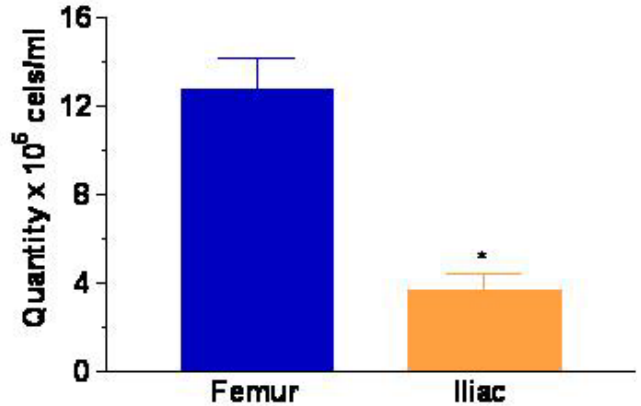
FIGURE 4 - Mononuclear cell count in different volumes of epiphysis femur and iliac crest, volume of 1,0 ml (n=8) 3,6.10 6 ± 0,50 cell /ml and volume of 3,0 ml (n=22) 12.10 6 ± 1,37 cell/ml (test t *p<0.05)